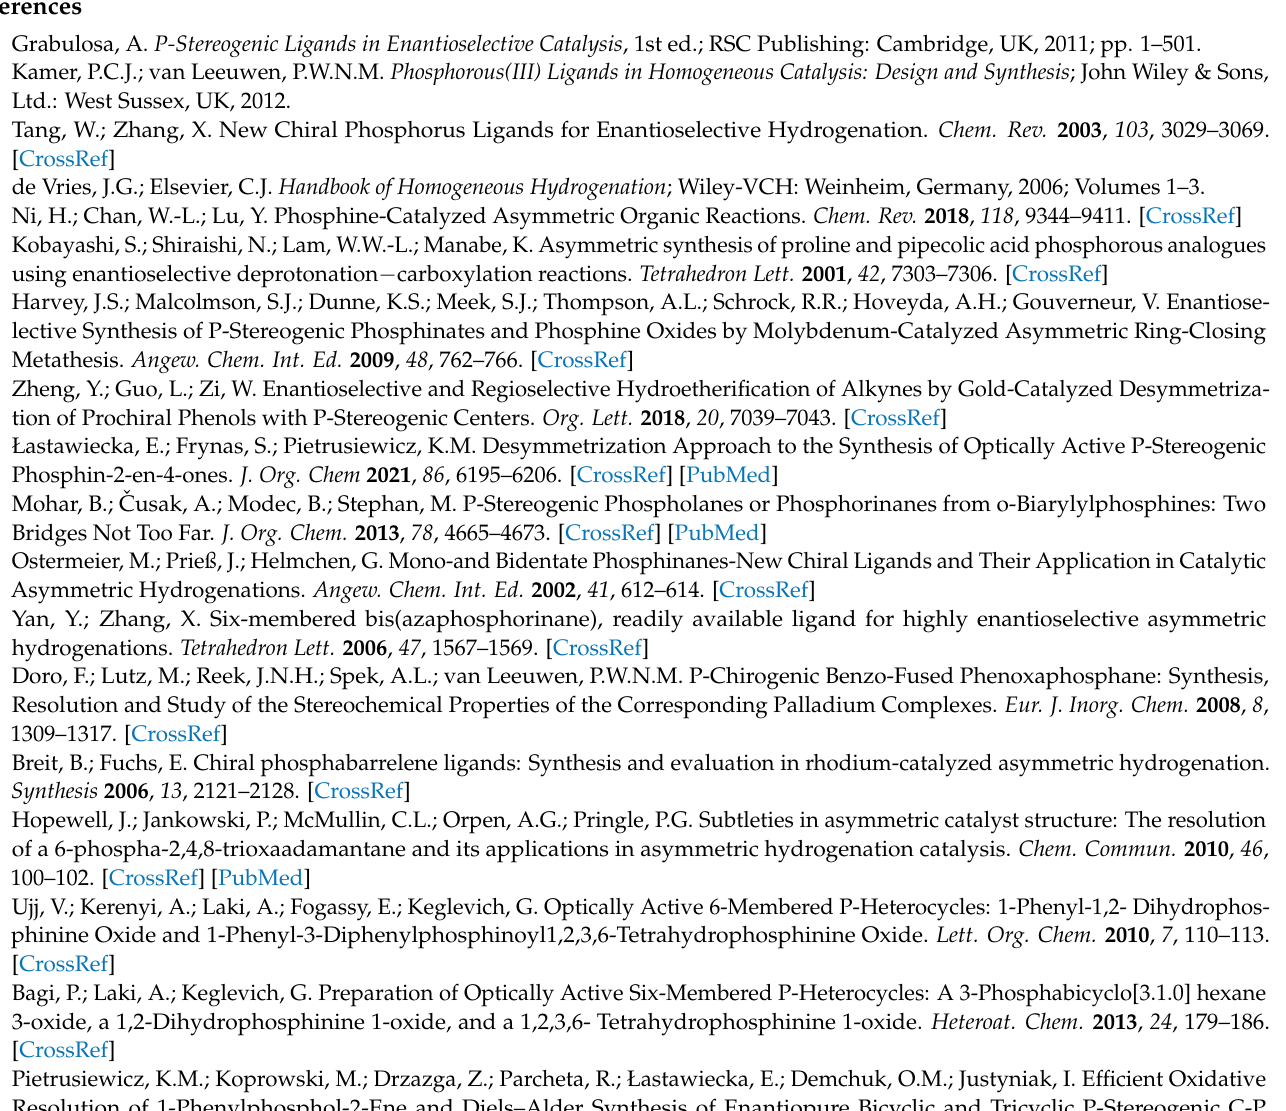
Supplementary Materials: Table S1: Data search in the Cambridge Structural Database (CSD